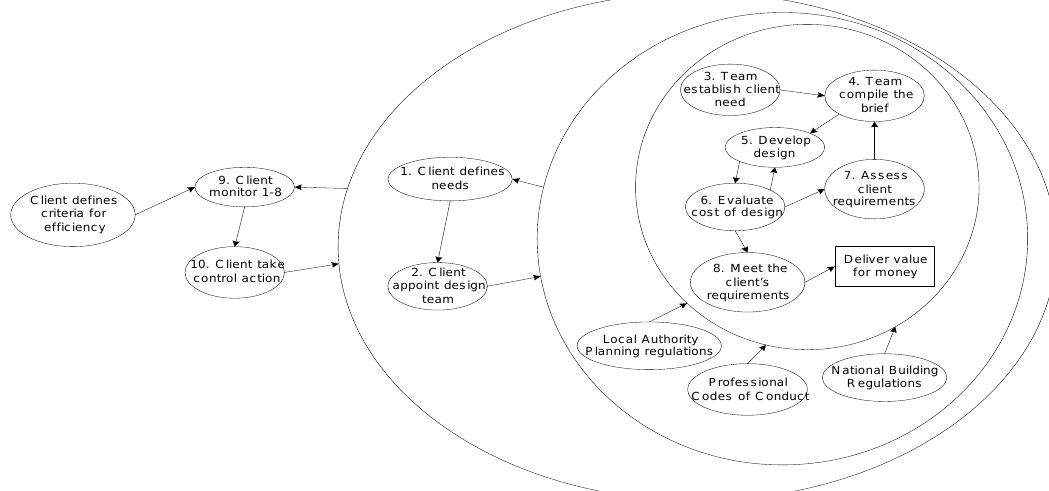
Figure1 Initial conceptual model for the cost management